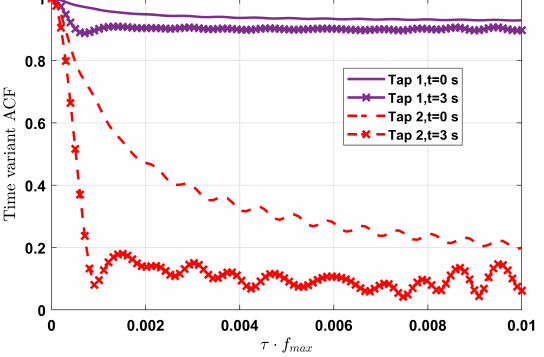
Figure 4. The absolute values of the time-variant space ACF of different taps of the proposed HST channel model at different time